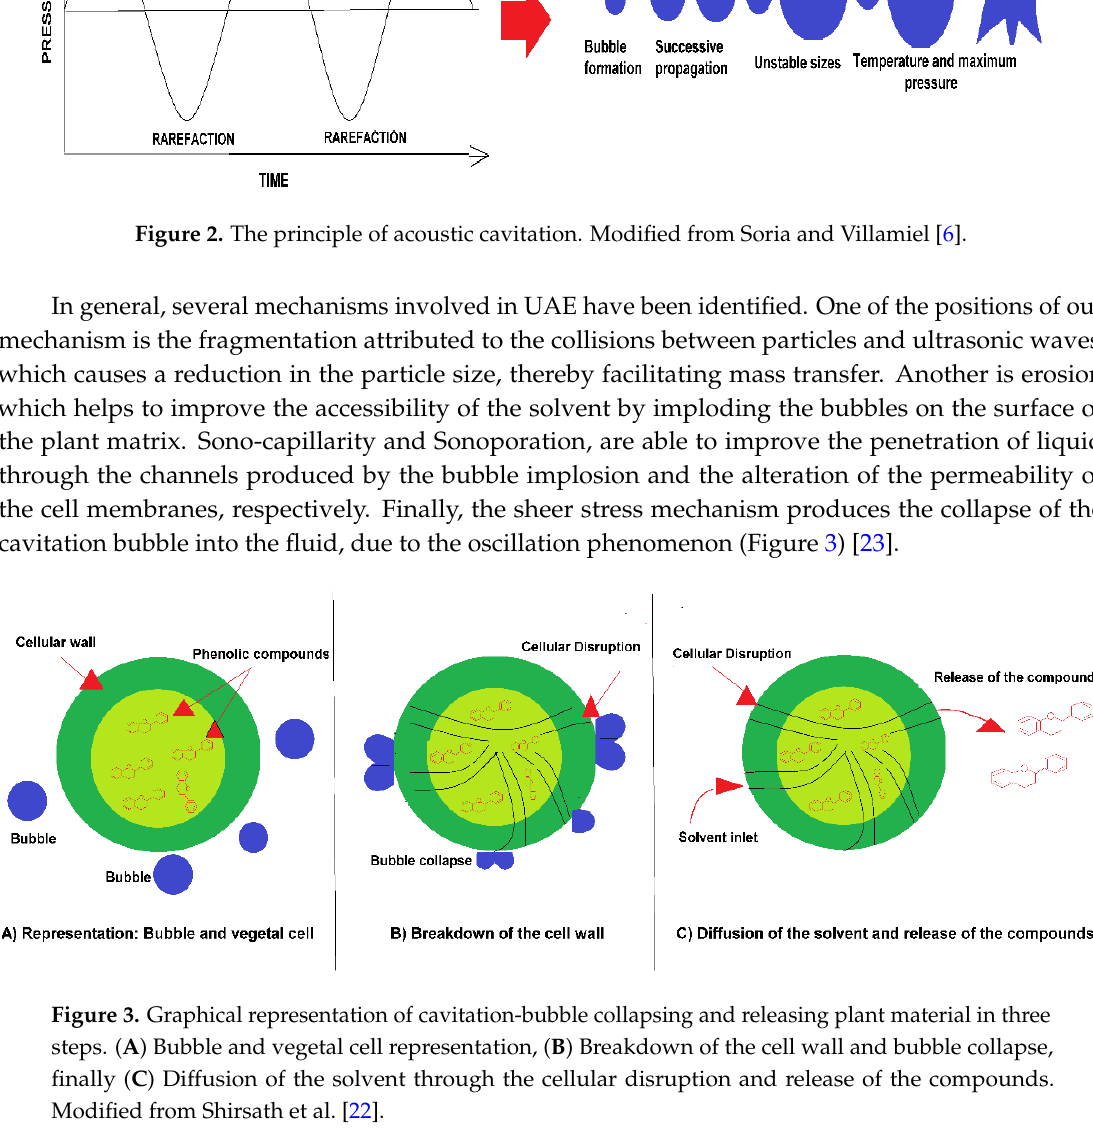
Figure 4. Representation of an Ultrasound system coupled to a probe. Modification from Barba et al. [25]. 4. Effect of Involved Variables of UAE in Efficiency and Yield During the UAE there are variables that are directly related to extraction efficiency and yield, such as the way in which the ultrasound irradiation is applied (directly or indirectly), and the extraction conditions: time, temperature, solvent type and concentration used [8]. The following is an analysis of the influence on efficiency and yield on the main variables reported in UAE studies of phenolic compounds. In Table 3 some examples of these common variables involved in UAE efficiency and yield compare to conventional methods are summarized. Table 3. Effect of involved variables of Ultrasound Assisted Extraction (UAE) in polyphenols extraction yields from different vegetable sources. Variable Involved